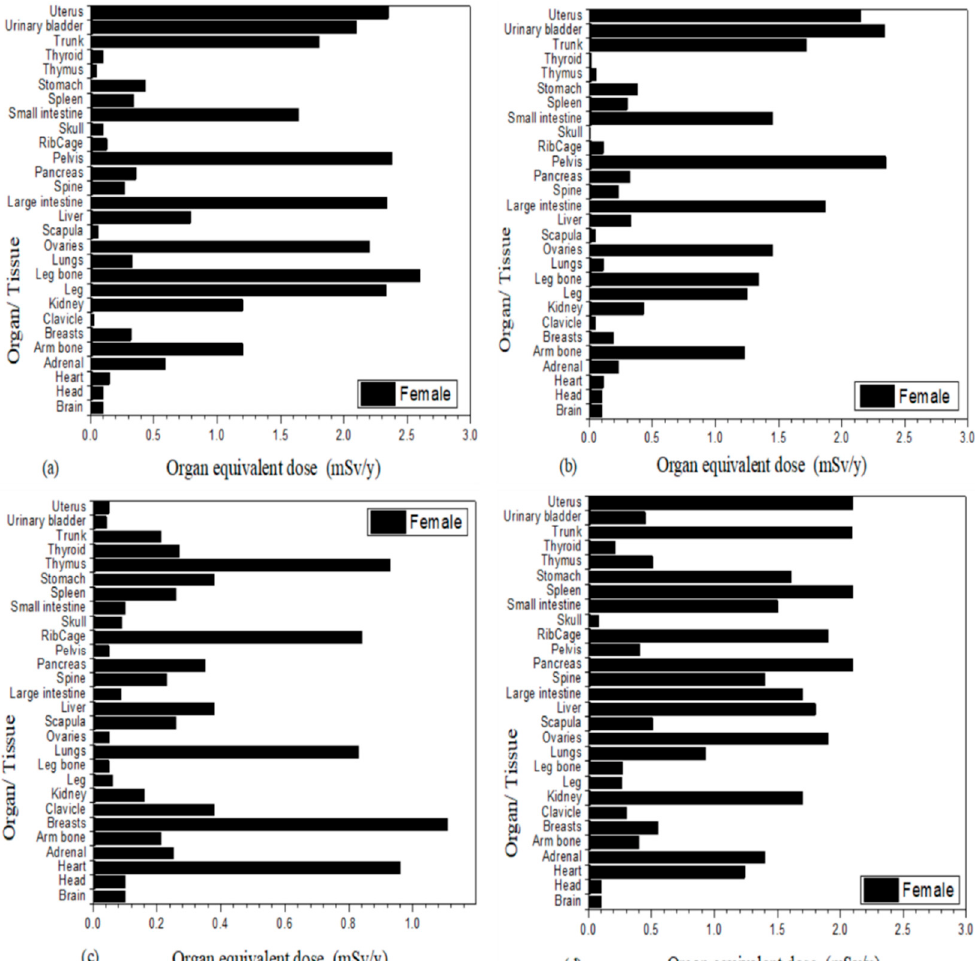
Figure 3. Organ equivalent dose (mSv/y) for 28 organs using the MIRD5 mathematical female phantoms, for garment items ( a ) S05; ( b ) S08; ( c ) S09; and ( d )